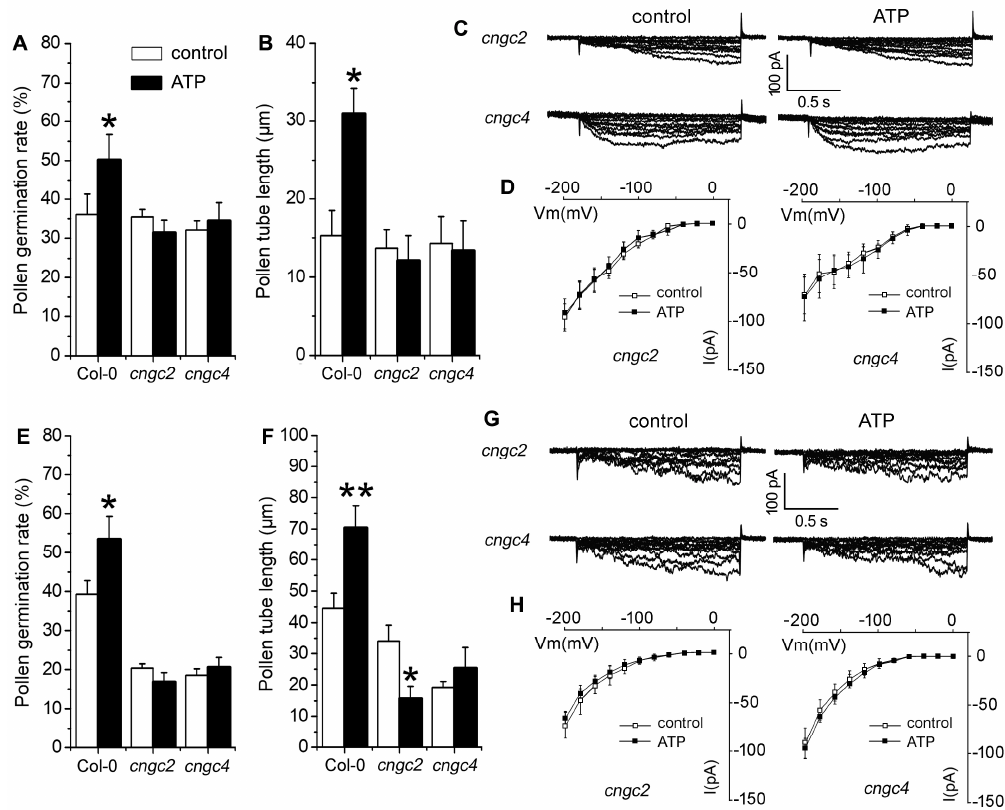
Figure 8. CNGC2 and CNGC4 are involved in eATP-regulated PG, PTG, and ion influx. Two CNGCs null mutants ( cngc2 , cngc4 ) were used. ( A – D ) show the effects of ATP on PG ( A ) and PTG ( B ) in medium containing 0.1 mM KCl with corresponding K + influx current traces ( C ) and I-V relationship curves (( D ), n = 7). ( E – H ) show the effects of ATP on PG ( E ) and PTG ( F ) in medium containing 0.1 mM CaCl 2 with corresponding Ca 2+ influx current traces ( G ) and I-V relationship curves (( H ), n = 7). In the pollen germination experiment, at least 300 pollen grains or 150 pollen were counted or measured; data from 3 replicates were combined to obtain the mean ± SD. Student’s t test p values: * p < 0.05, ** p < 0.01. In the patch clamp experiment, data from at least 7 pollen protoplasts were recorded and combined to obtain the mean ± SD.